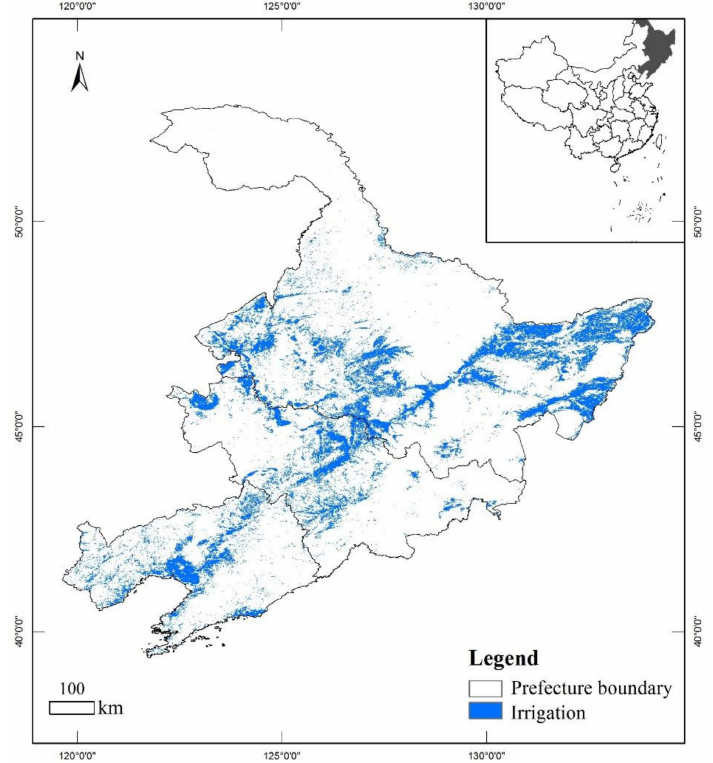
Figure 5. Spatial distribution of estimated irrigated fields in Northeast China based on this method. Blue pixels indicate the irrigation